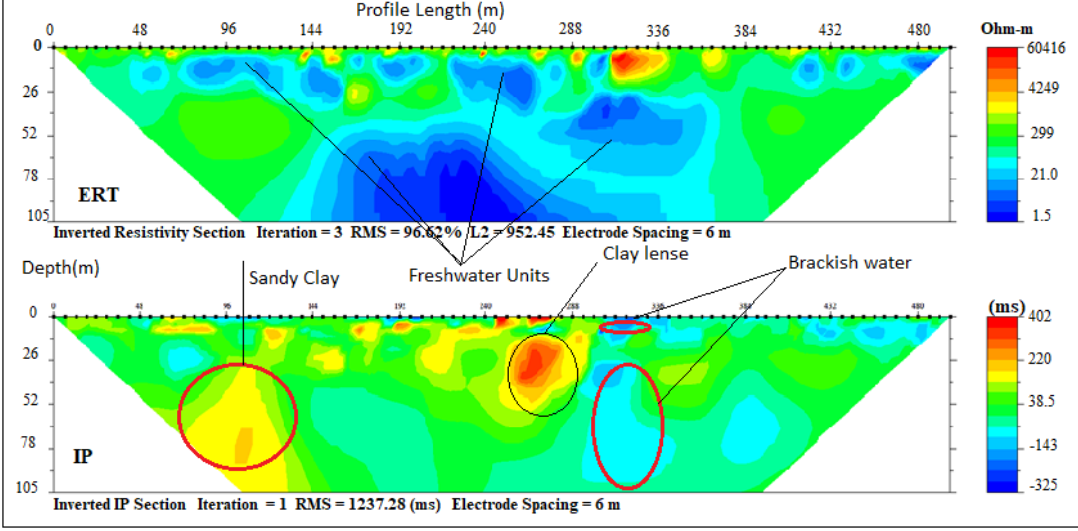
Figure 9. Inverted resistivity and IP cross-sections Abule-Obi (Profile section P7).